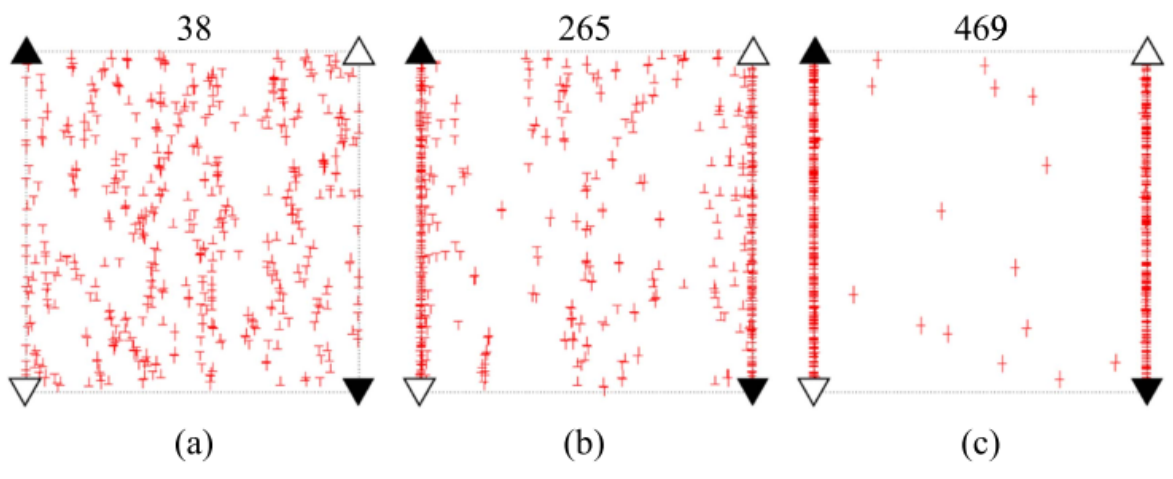
Figure 19. Dislocation positions after ultrasonic treatment during 1200 oscillation periods for different values of parameter K = 2 π ( 1 − ν ) B τ m + 1 / Gb ω : ( a ) K = 0.05; ( b ) K = 0.5; ( c ) K = 2. Black triangle schematically indicates positive wedge disclination, white triangle indicates negative wedge disclination. The dotted lines display the square-shaped grain. The corresponding values of the total number of dislocations entered into the vertical grain boundaries are indicated above the figures [111].